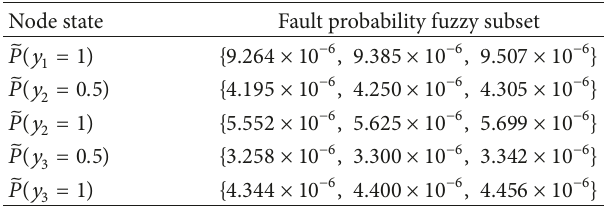
Table 8: Probabilities fuzzy subsets of leaf nodes and intermediate nodes.